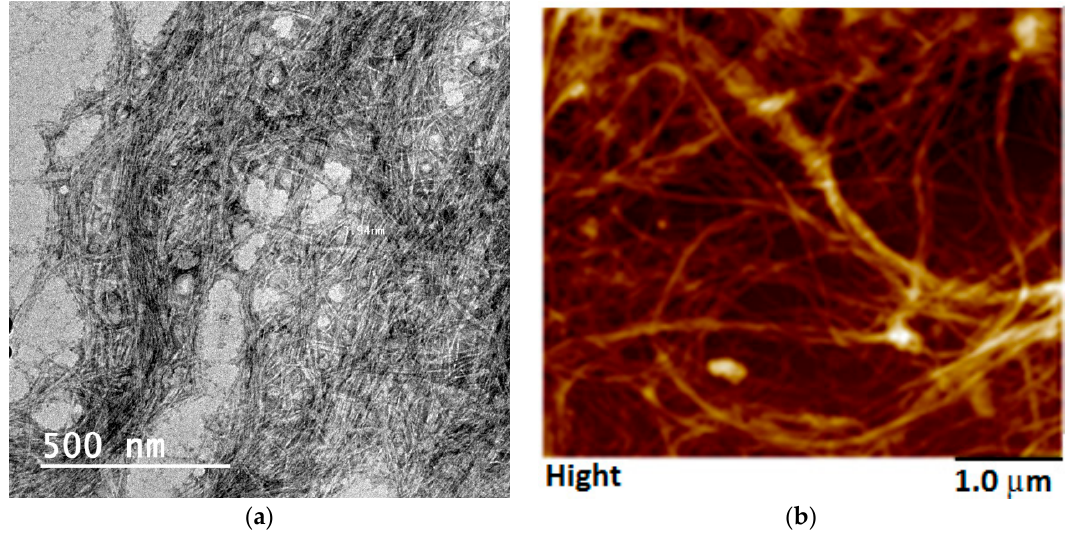
Figure 1. TEM image ( a ) and AFM image ( b ) of RSNF isolated from xylanase-treated rice straw unbleached neutral sulfite pulps.